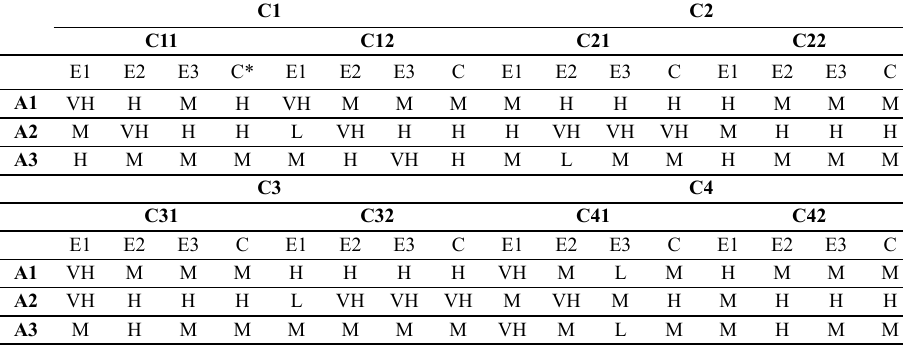
Table A4. Linguistic evaluation matrix of